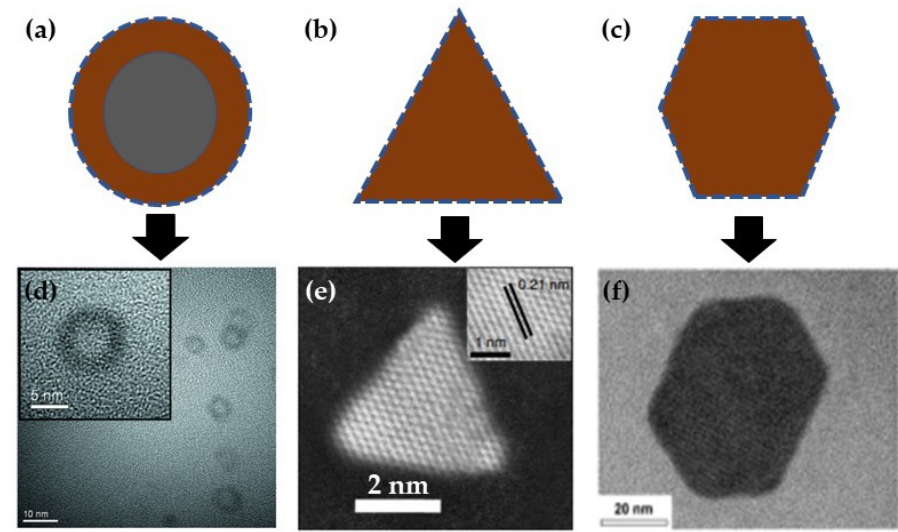
Figure 2. Illustrations of the shapes and TEM images of ( a , d ) hollow carbon dots (HCDs, adopted with permission from [85], Elsevier BV), ( b , e ) triangular carbon dots (triangular CDs, adopted with permission from [87], Springer Nature) and ( c , f ) single-crystal hexagonal graphene quantum dots (adopted with permission from [88], American Chemical Society).